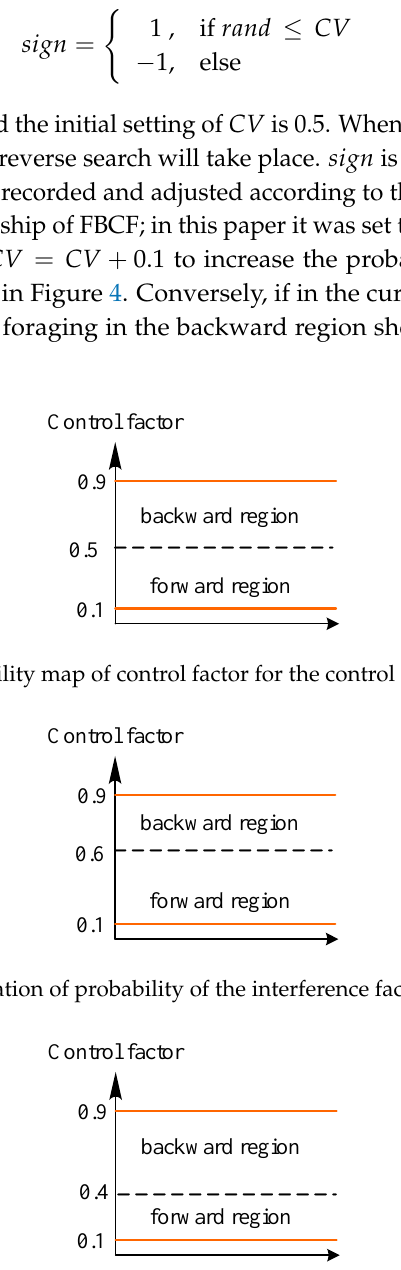
Figure 2. Influenced characteristics of a ripple wave at the ripple constant value, H = 0.1.